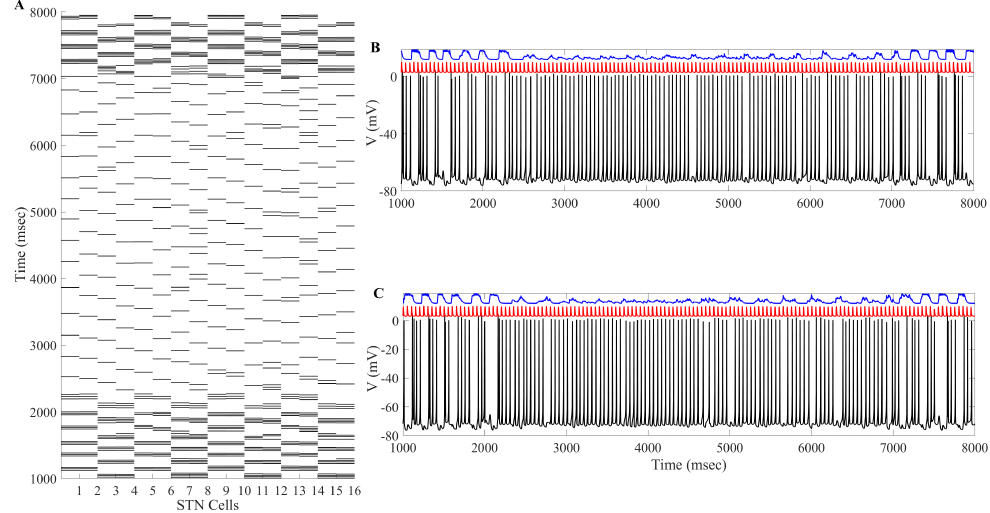
Figure 11. Example of aLFPDBS. ( A ) Spike times of 16 STN neurons. acDBS is on from 2000 to 7000 ms with a 0 = 6 and intt = 300 ms. Before stimulation, there are two synchronized clusters, as shown in figure panel (a) in Section 4.1.3. During the stimulation period, the bursting dynamic is largely eliminated, and the synchronized clusters no longer exist. Once stimulation is stopped, the synchronized clusters reemerge. ( B ) Relay performance of TC 1 . ( C ) Relay performance of TC 2 . In both ( B , C ), the top trace in blue is the total GPi synaptic input, the middle trace in red is the excitatory signal, and the bottom trace in black is the TC voltage. TC relay performance noticeably improves during the stimulation